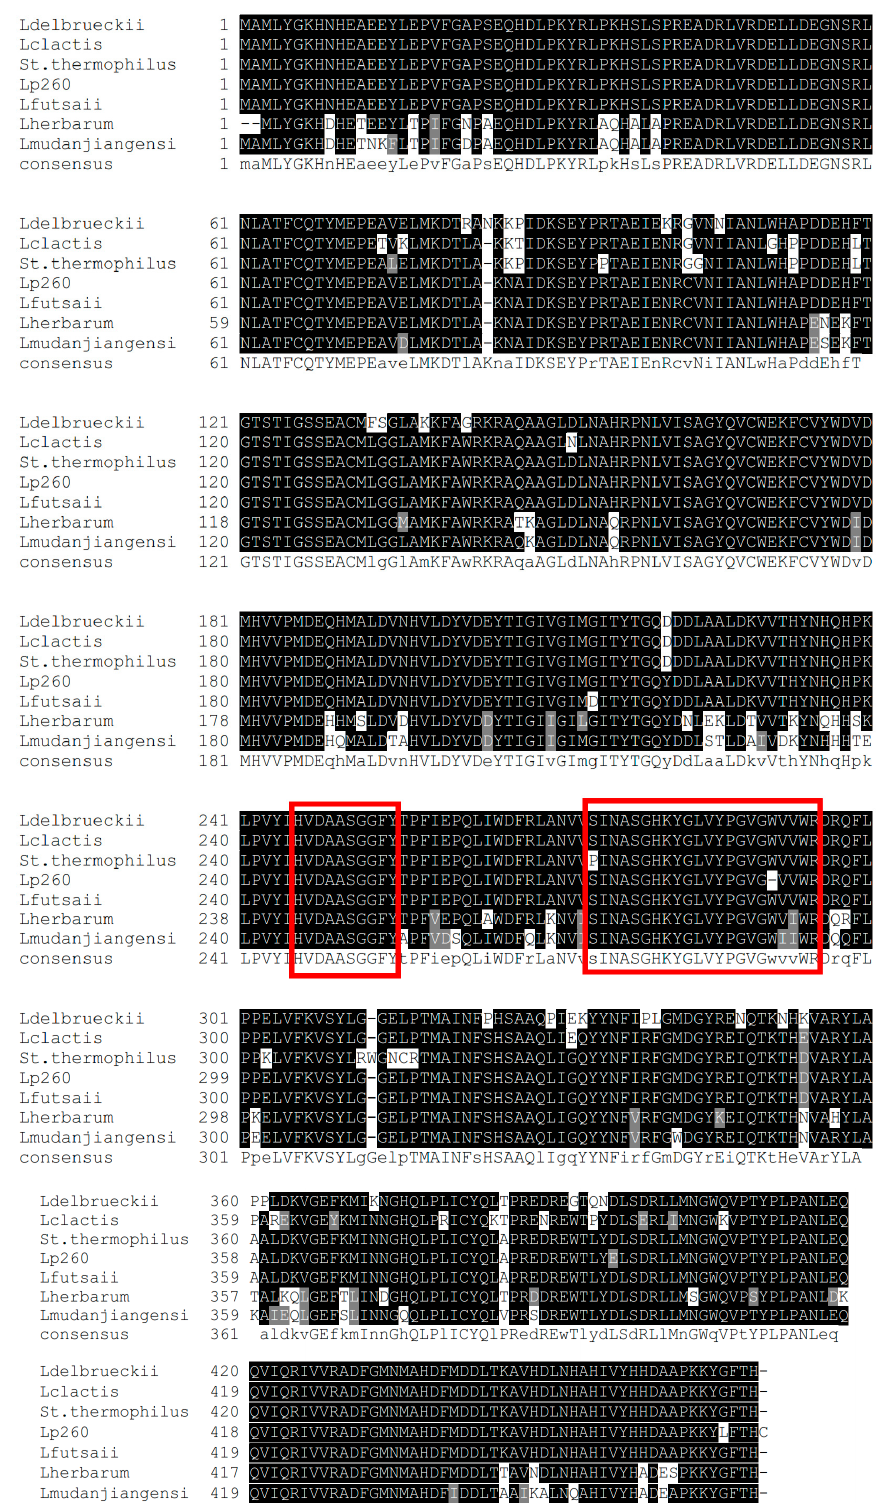
Figure 7. Alignment of amino acid sequences of GAD from L. plantarum FNCC 260 and six other GADs from LAB. The consensus sequence HVDAASGGF indicated by a smaller red box is highly conserved in GAD sequences. The sequence SINASGHKYGLVYPGVGWVVWR in the bigger red box is the PLP-binding domain [49]. GadB sequences shown are from L. delbrueckii (Ldelbrueckii), Lactococcus lactis (Lclactis), S. thermophilus (St. thermophilus), L. plantarum FNCC 260 (Lp260), L. futsaii (Lfutsaii), L. herbarum (Lherbarum), and L. mudajiangensi